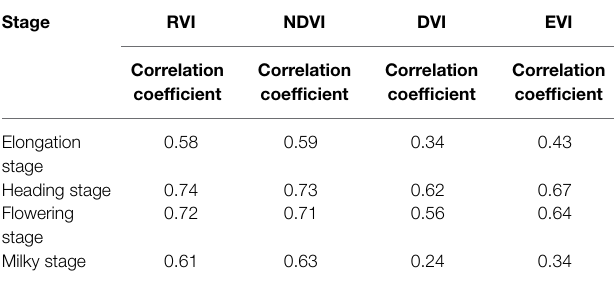
TABLE 3 | Summary of optimal parameters of vegetation